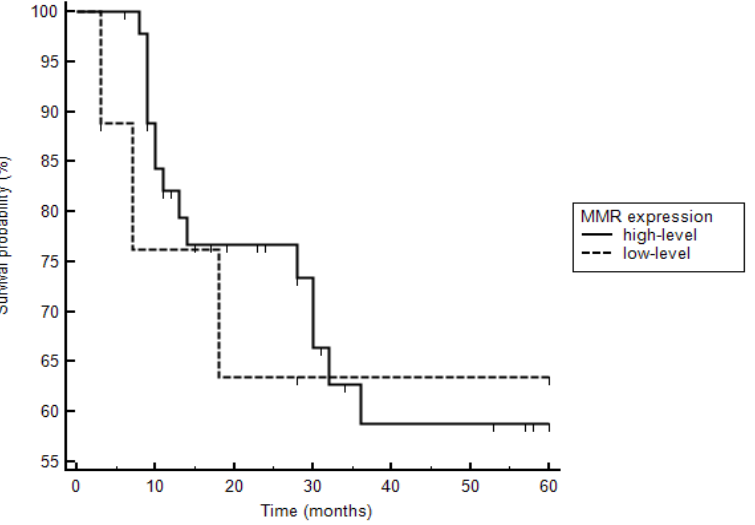
Figure 2. Kaplan–Meier curves are demonstrated with respect to deaths in patients with high- and low-level mismatch repair protein (MMR) expression. Three of six patients with low-level MMR expression died, whereas 15 of 47 patients with high-level MMR expression died (hazard ratio: 1.2, CI 0.31 to 4.3; p = 0.81).